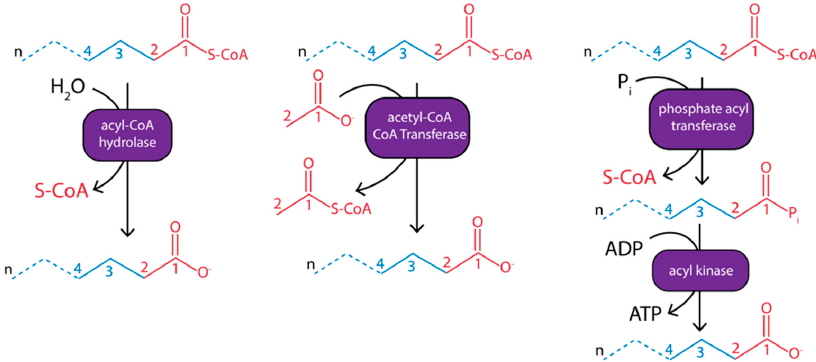
Figure 3. Terminal enzymes for hydrolyzing the CoA-ligated products of reverse β -oxidation to release a carboxylate and